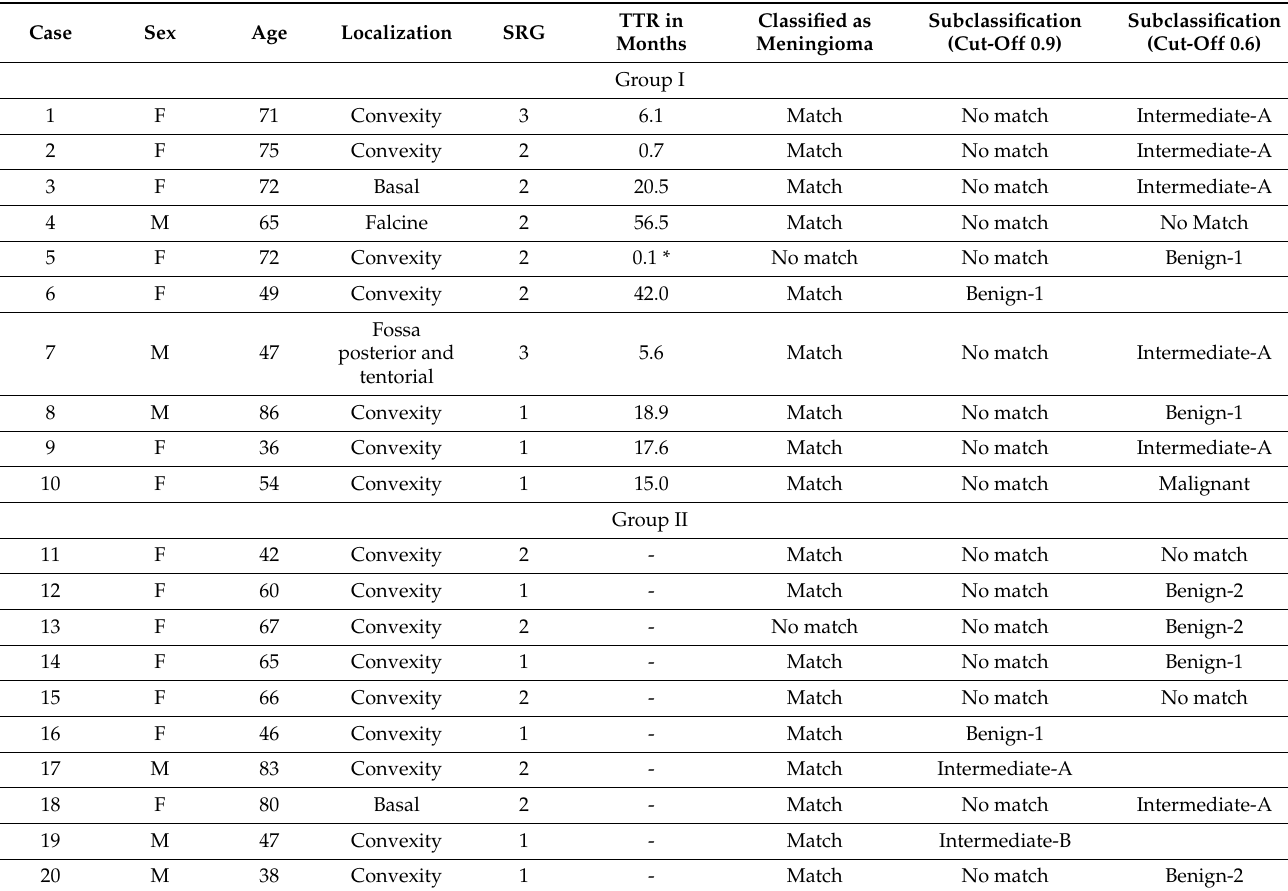
Table 1. Patient characteristics and methylation